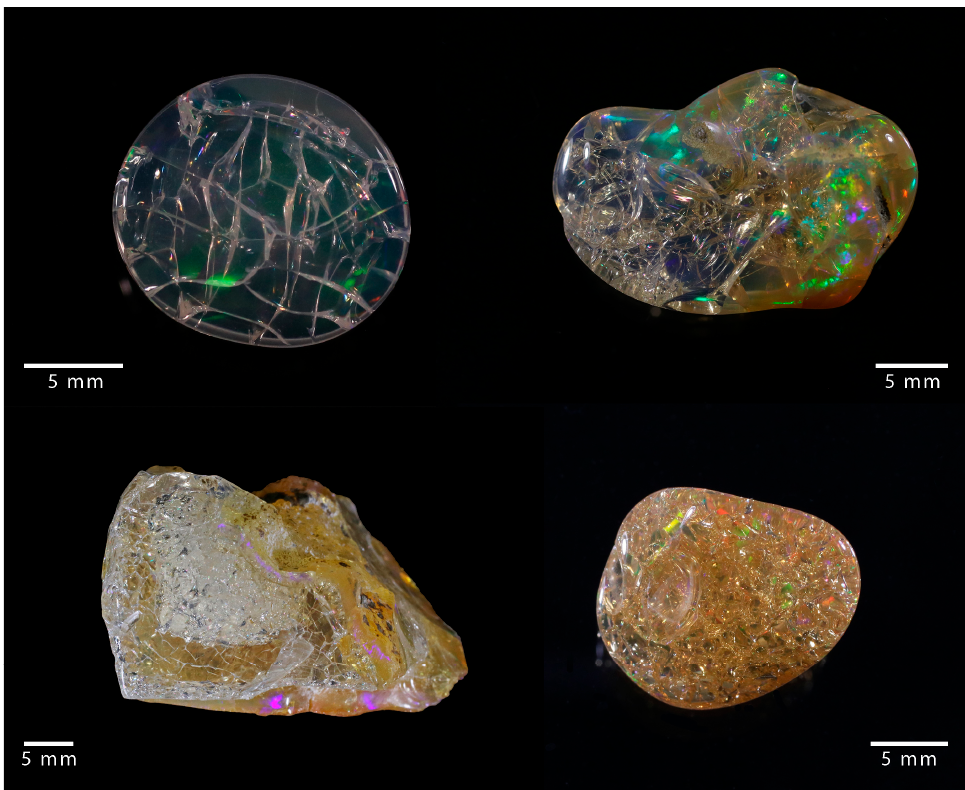
Figure 1. Examples of cracked opal, where a network of fractures developed.